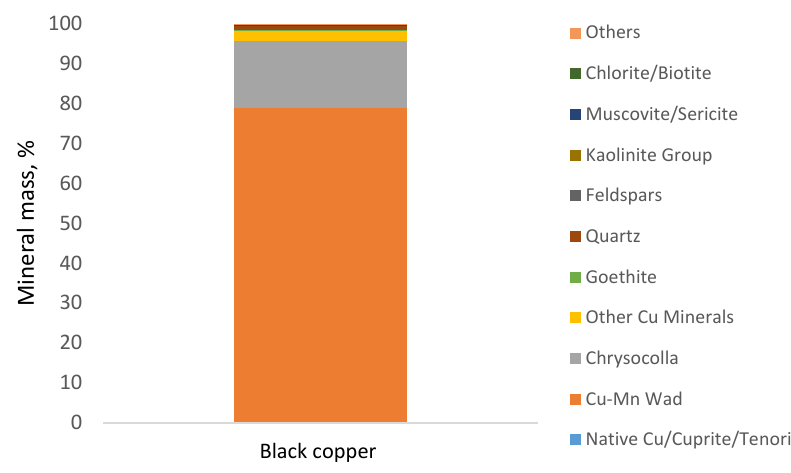
Figure 1. Detailed modal mineralogy.